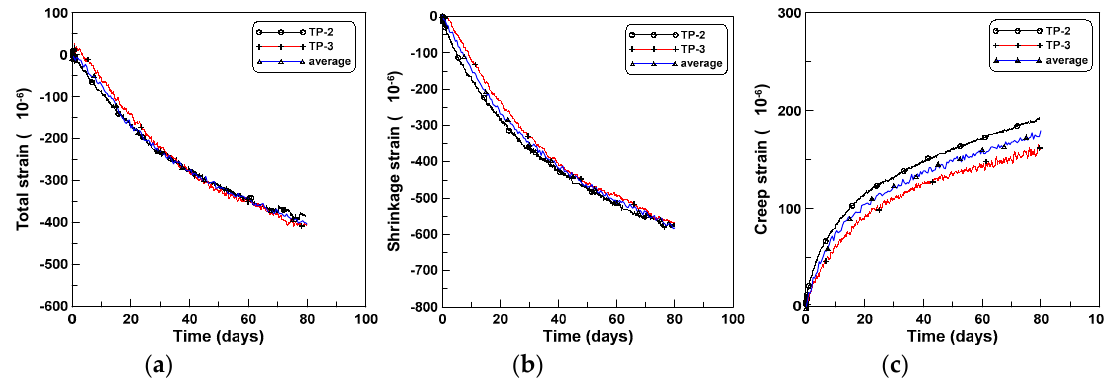
Figure 6. Tension creep tests of TP-2 and TP-3 test series: ( a ) total strain, ( b ) shrinkage strain, and ( c ) creep strain.